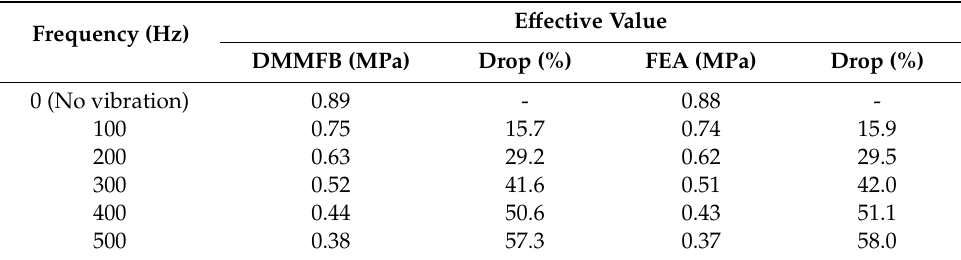
Table 6. Effective value of the shear stress without and with 0.25 g vibration applied at different Table 6. E ff ective value of the shear stress without and with 0.25 g vibration applied at frequencies. di ff erent